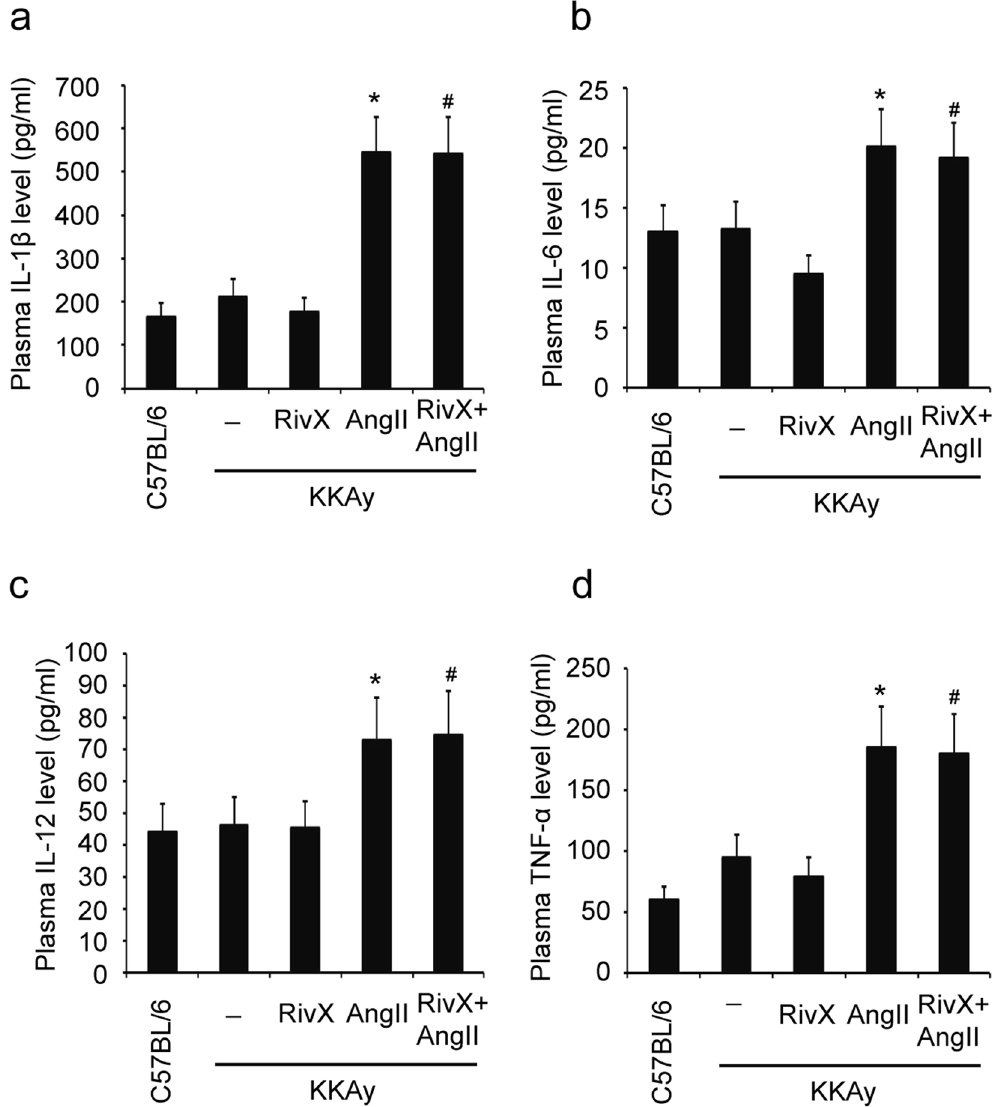
Figure 2. Rivaroxaban did not suppress procoagulation cytokine levels in the presence of AngII. Mice were administered orally with rivaroxaban (RivX, 5 mg/kg body weight/day), or infused with AngII (1,500 ng/kg/ min), or co-treated with RivX and AngII for 2 weeks. Blood was collected by cardiac puncture to determine the plasma levels of IL-1 β ( a ), IL-6 ( b ), IL-12 ( c ), and TNF- α ( d ) using ELISA. The bars show the mean ± SEM (n = 6). * P < 0.05, compared with the KKAy blank group; # P < 0.05, compared with the AngII treatment